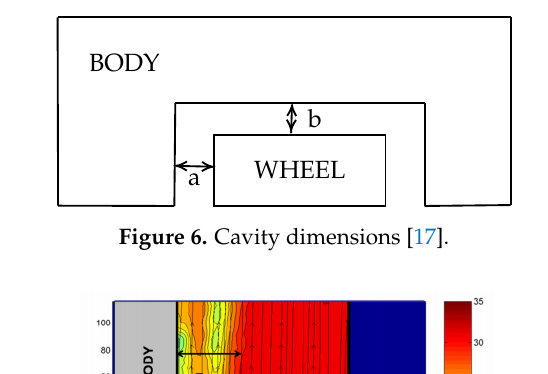
Figure 5. Experimental model by Cazat and Gilliéron [17].